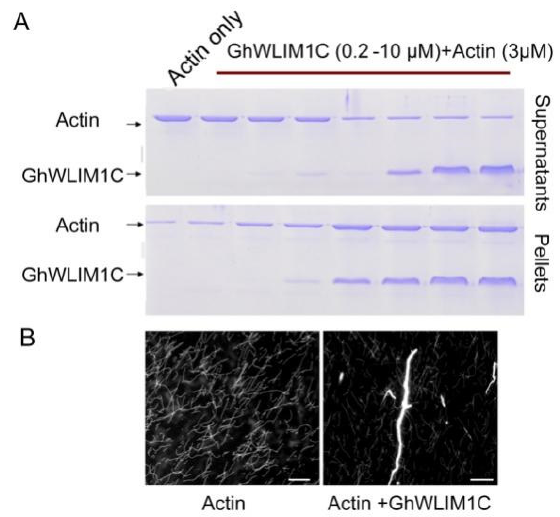
Figure 4. GhWLIM1C bundles actin filaments in vitro. ( A ) Low-speed cosedimentation assay of the actin-bundling activity of GhWLIM1C. The presence of GhWLIM1C in the pellet indicates its cosedimentation with F-actin. Lane 1, actin alone (3 µ M); lanes 2 to 8, actin (3 µ M) incubated with 0.2, 0.5, 1, 2, 4, 8, and 10 µ M GhWLIM1C, respectively. ( B ) Actin bundles visualized by